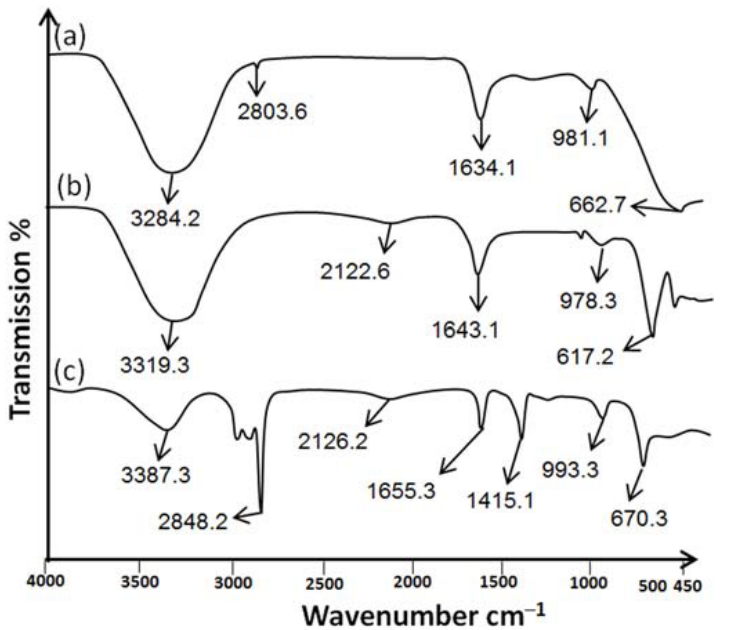
Figure 4. ATR-FTIR of ( a ) Citrus limon extract, ( b ) Sulfur nanoparticles, and ( c ) Nanohydrogel embedded with SNPs of Citrus limon